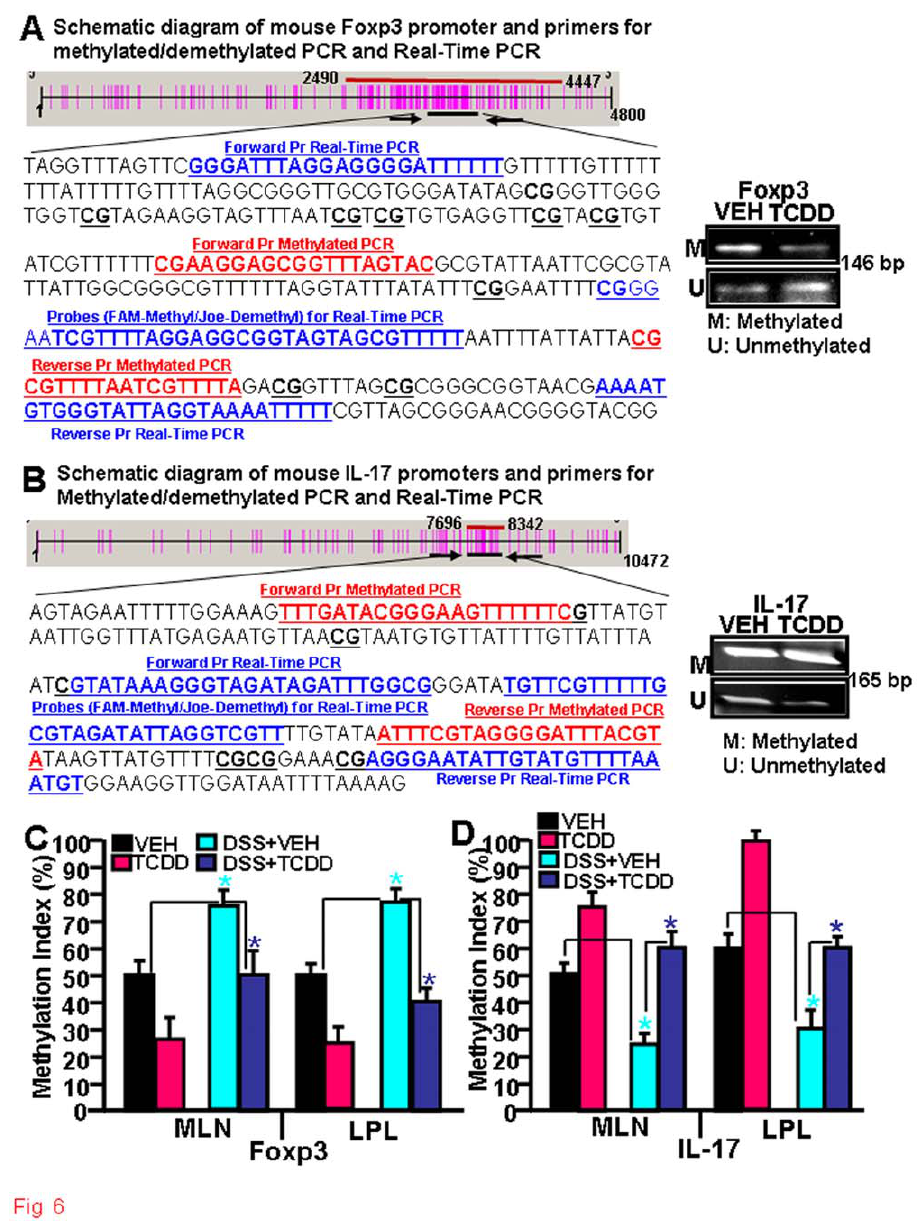
Figure 6. Effect of TCDD on methylation of Foxp3 and IL-17 promoters during colitis. A-B: Phyisical map generated using Methylprimer Express software (v 1.0) is demonstrating the distribution of CpG islands (vertical red bars) and the position of the MSP primer pairs on the mouse Foxp3 (A) and Il-17 (B) promoter. PCR amplicons of promoter region of Foxp3 gene amplified by methylated or demethylated sets of primers in T cells activated in vitro with anti-CD3 + anti-CD28 Abs, treated in the presence of VEH or TCDD, has also been depicted in the right panels. C-D: Real Time PCR demonstrating methylation/demethylation status of Foxp3 and IL-17 promoters in MLN and LPL in vivo . MLNs and LP lymphocytes were isolated from the four groups of mice as described in Fig 1. Data (mean 6 SEM) from 3 independent experiments are shown. Comparisons were made between VEH vs DSS + VEH groups as well as between DSS + VEH vs DSS + TCDD groups. Asterisks (*) represent statistically significant (p , 0.05) difference between VEH vs DSS + VEH treated groups, and between DSS + VEH vs DSS + TCDD treated groups.